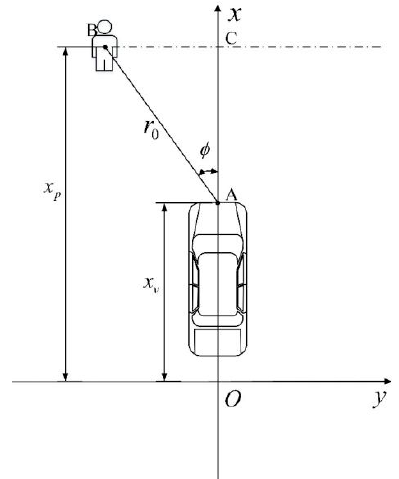
Figure 4. Vehicle and pedestrian position coordinates.